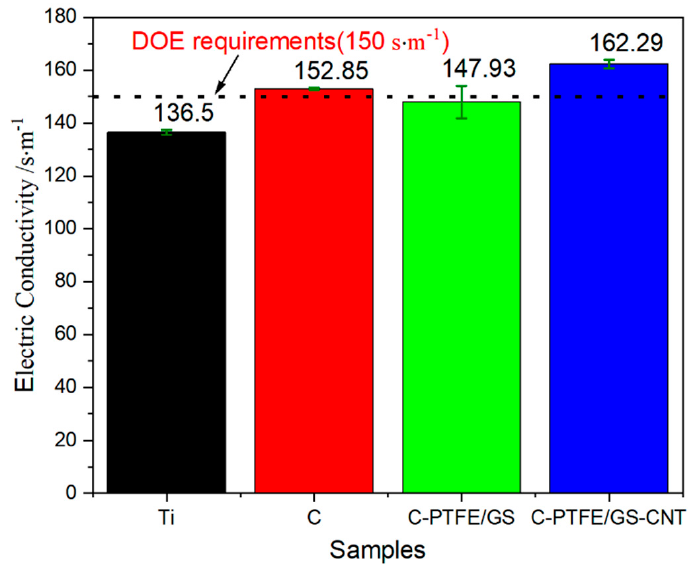
Figure 10. The conductivity of different coatings was compared with DOE requirements.